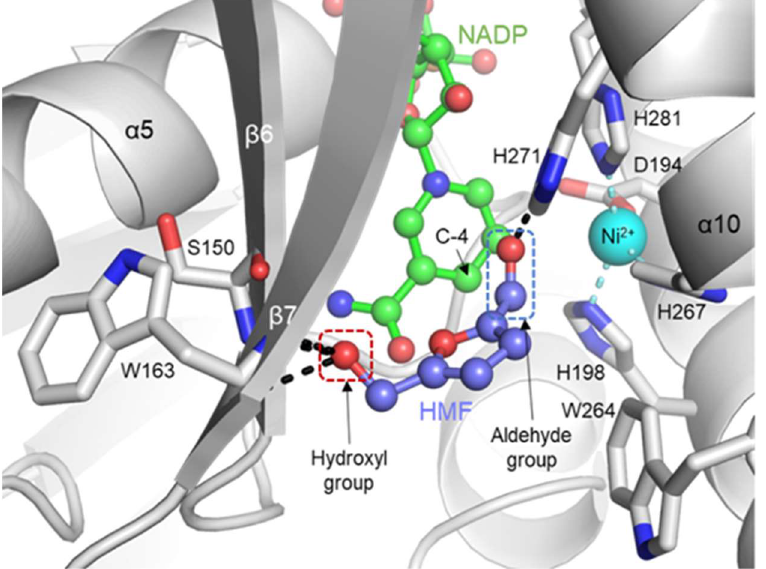
Figure 5. YugJ-HMF complex model based on molecular docking. HMF was docked on the YugJ- NADP-Ni 2+ model. HMF and NADP are represented by light blue and green ball-and-stick models, respectively. The Ni 2+ ion is represented by a cyan sphere. The HMF-binding residues and Ni 2+ - coordinating residues of YugJ are shown as gray sticks on the YugJ structure (gray ribbons). The hydrogen bonds of HMF with YugJ residues are represented by black dotted lines. The aldehyde and hydroxyl groups of HMF are indicated by blue and red dotted boxes, respectively.